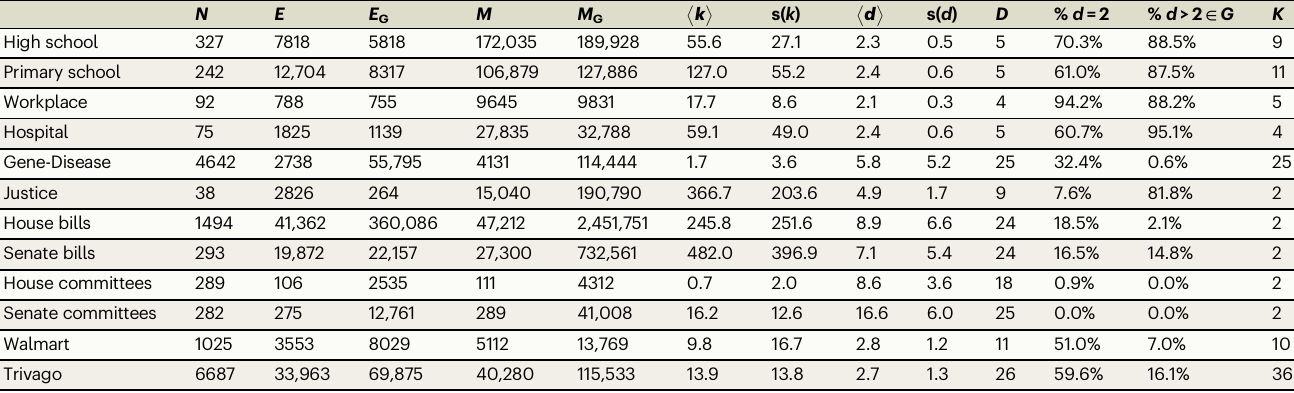
Table 1 | Summary of higher-order